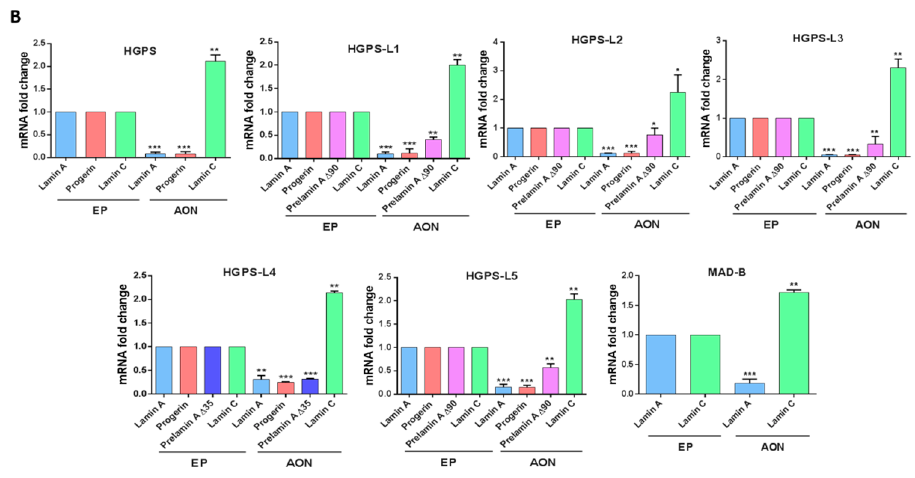
Figure 2. Morpholino treatment downregulates aberrant Prelamin A transcripts production without causing aberrant splicing in off-target genes. ( A ) Upper panels: Semi-quantitative RT-PCR analyses showing Lamin A, Progerin (Prelamin A Δ 50), Prelamin A Δ 35, β -actin and GAPDH mRNA levels in Hutchinson-Gilford Progeria Syndrome (HGPS) and HGPS-like fibroblasts treated with morpholino antisense oligonucleotides (AON, 20 µM each) relative to Endo-porter (EP, which is the AON vehicle used as Control), scrambled oligonucleotides (Scr) treated cells and untreated cells (NT). Fragments covering all exons of β -actin (3 fragments, 5 exons) and GAPDH (2 fragments, 9 exons) cDNAs were amplified for each couple of AON used. Given that in patients HGPS-L2 and -L3, the same AON couple as in patient HGPS-L1 was used, the splicing study was only partially replicated. Lower panels: Relative levels of Lamin A, Progerin, Prelamin A Δ 35 to GAPDH ex7–ex9 and the indicated fragments of β -actin and GAPDH transcripts ratios using Image J software and compared to EP treated cells. (mean ± SEM, n = 4, Student’s t-test, * p < 0.05, ** p < 0.01, *** p < 0.001, AON-treated vs. EP-control). ( B ) Quantitative RT-PCR analyses of Lamin A, Progerin (Prelamin A Δ 50), Prelamin A Δ 35, Prelamin A Δ 90 (when detected at baseline, in EP assays), Lamin C and GAPDH mRNA levels in HGPS, HGPS-like and Mandibuloacral Dysplasia type B (MAD-B) fibroblasts treated with AON, 20 µM each relative to Endoporter (EP: vehicle used as Control). The fold change of each transcript was determined by normalizing its value to that of GAPDH for each condition. (mean ± SEM, n = 4, Student’s t-test, * p < 0.05, ** p < 0.01, *** p < 0.001, experimental vs. control).